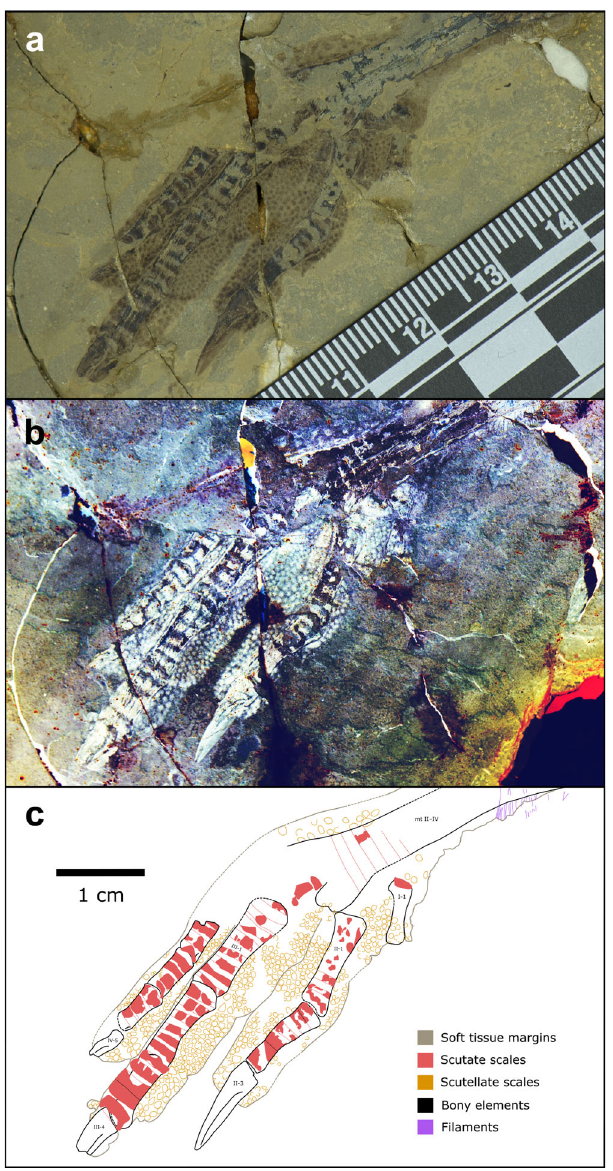
Fig.6|Near-complete,articulatedrightpesof Yanornis STM9-531. Fossilunder a white light and b laser-stimulated fl uorescence. c Interpretive drawing, where solid lines indicate preserved structural boundaries, and dashed lines represent assumed or completed boundaries.